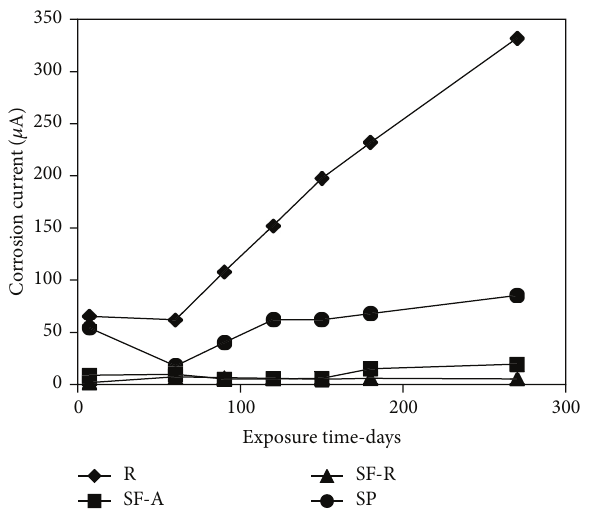
Figure 7: Corrosion current density versus 𝐸